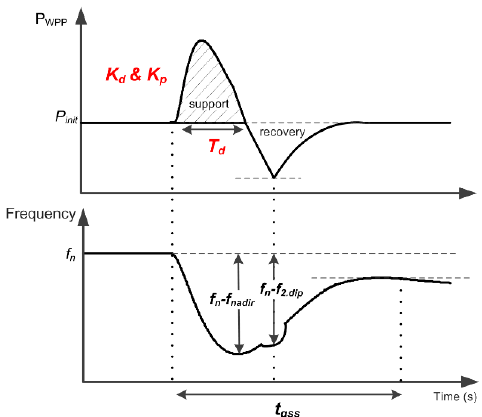
Figure 4. Illustration of synthetic inertial response of wind power plants (WPPs) with possible impact on power system frequency response. on power system frequency